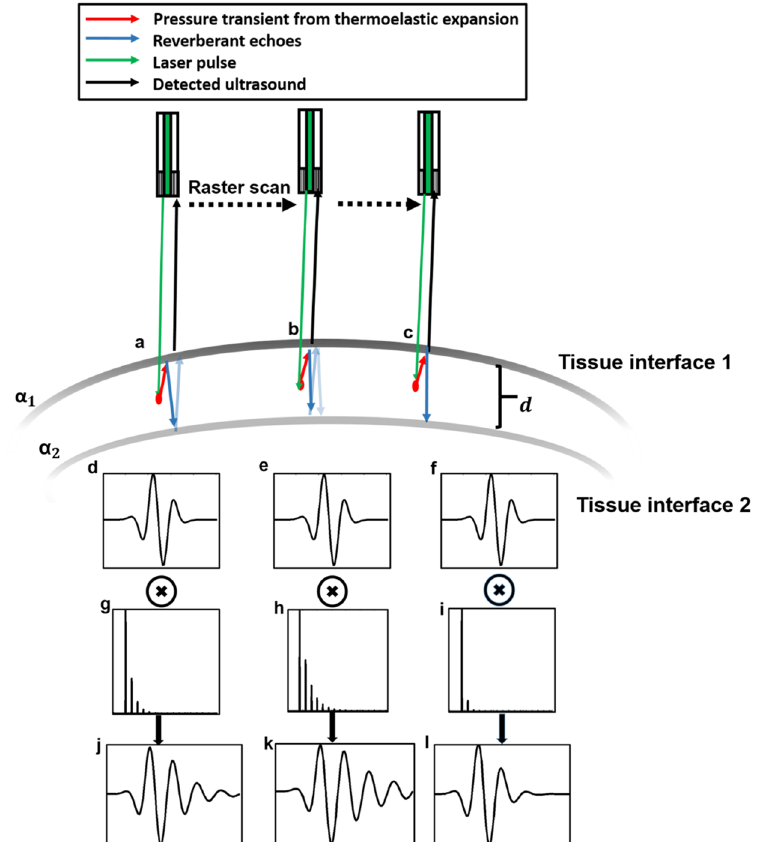
Figure 1. Schematic showing photoacoustic signals detected with different reverberation responses at 3 points ( a – c ) during a raster scan. ( d – f ) Transducer impulse response. ( g – i ) Reverberation responses. ( j – l ) Detected photoacoustic signals. ⨷ Denotes the convolution operator. The reverberant echoes are denoted with lighter arrows to indicate reducing intensity. α 1 , α 2 denote the respective echogenicity of the two tissue interfaces separated by d